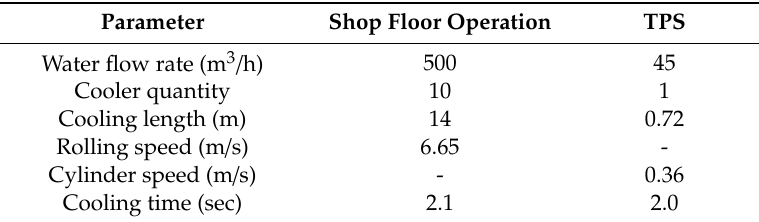
Table 2. Test conditions for comparison of TPS with shop floor operation.